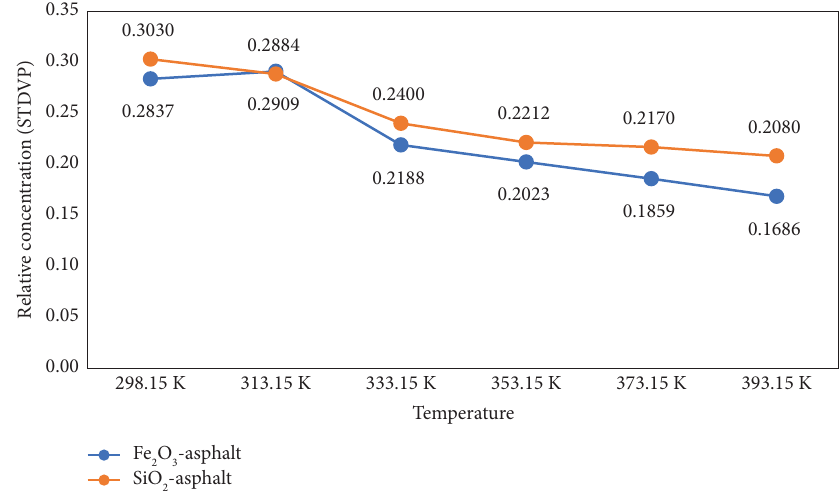
Figure 15: Standard deviation of relative concentration at diferent simulated temperatures. Table 7: Molecular dynamics calculation results for thermal conductivity. Crystal